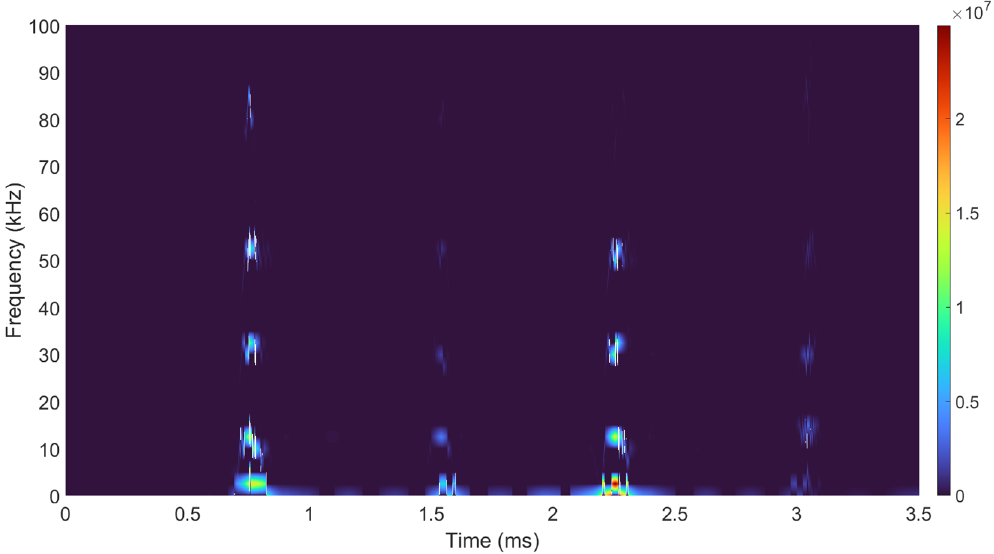
Figure 10. The Hilbert spectrum of the total acoustic signal.